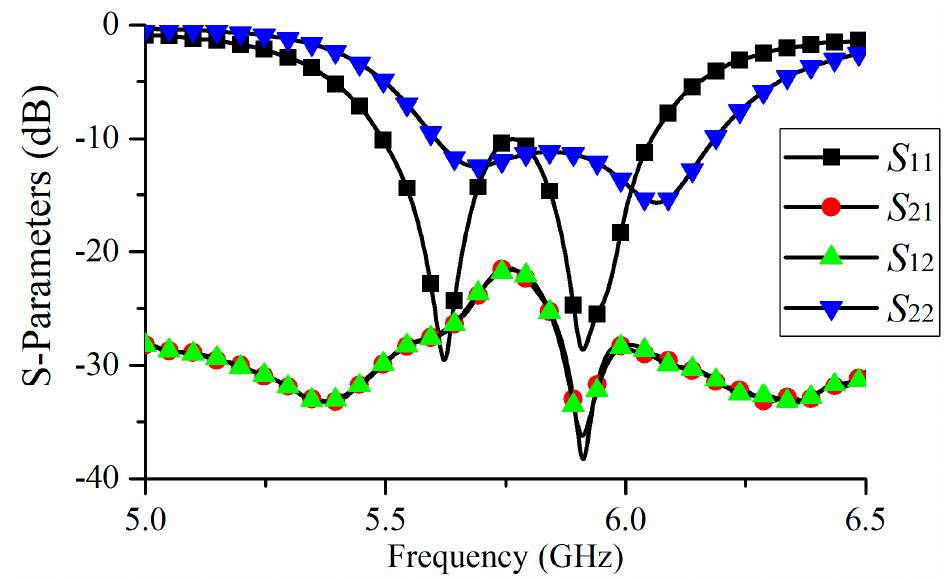
Figure 8. Simulation S -parameters of the proposed dual-polarized antenna.